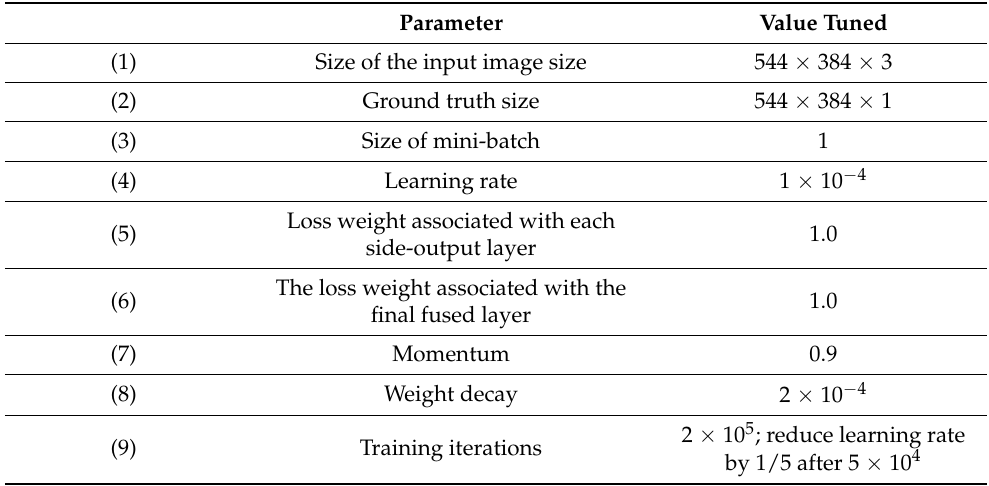
Table 2. Model parameters tuned for the